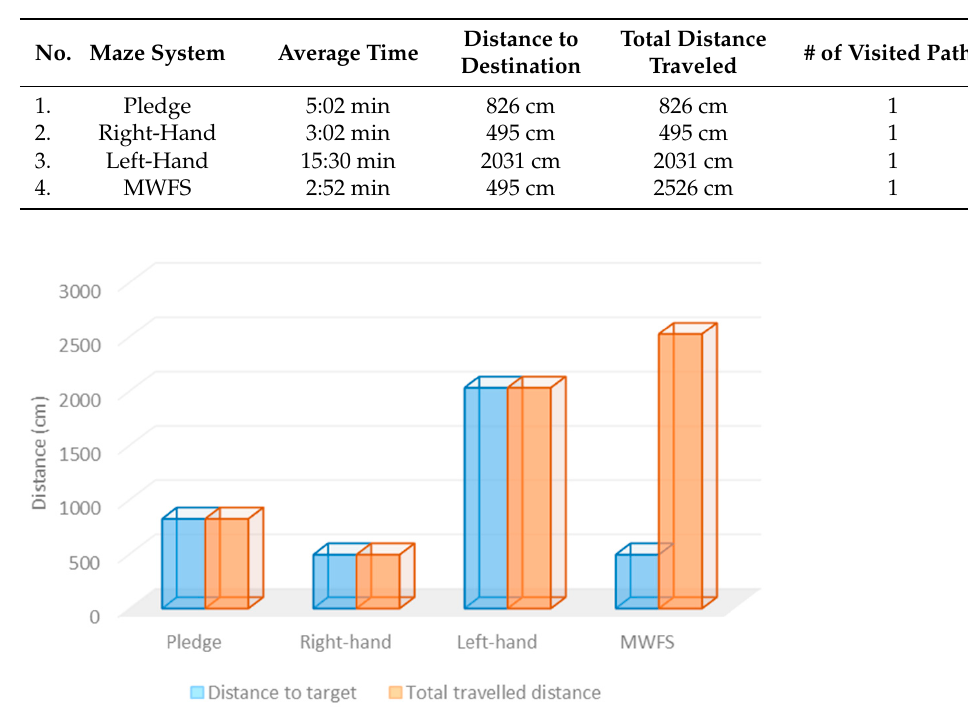
the left-hand algorithm required the maximum time to reach the target location, with a total traveled distance of 768